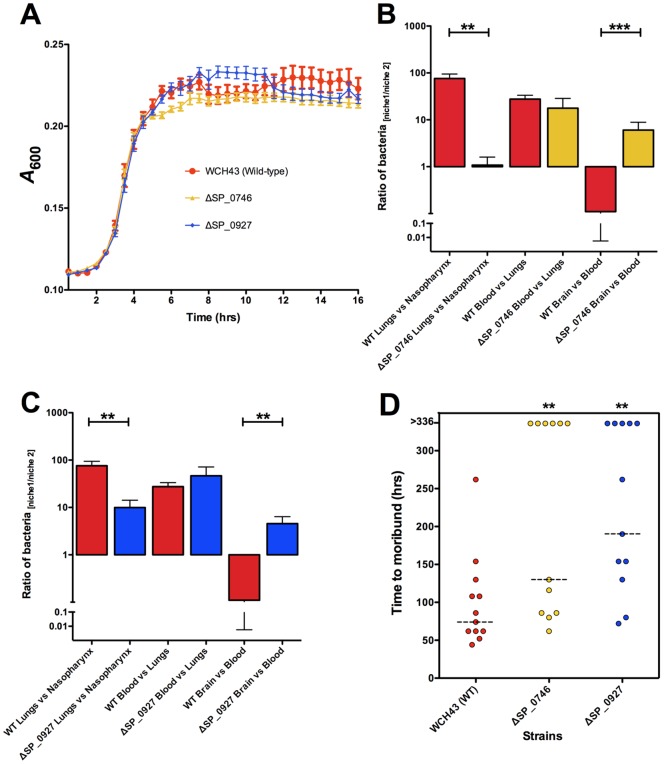
Characterisation of mutants of S. pneumoniae WCH43.(A), In vitro growth curves of mutants and wild-type. Data are mean ± SEM of 7 replicates for each time point for each strain. (B and C), Comparison of pathogenesis progress of mutants relative to wild-type; (B), ΔSP_0746; (C), ΔSP_0927. Data are mean ± SEM of pathogenesis ratios for 16–24 mice for the mutants, and 40 mice for wild-type. Data were analyzed by unpaired t-test, one tailed (**, P<0.01; ***, P<0.001). (D). Survival times for mice after intranasal (1×107 CFU) challenge with mutants and wild-type. Each datum point represents one mouse. Broken lines denote median survival time for each strain. Mice that survived beyond 14 days are indicated at the top of the figure as >336. ** P<0.01; Mann-Whitney U-test, one-tailed. NS =  Not significant.